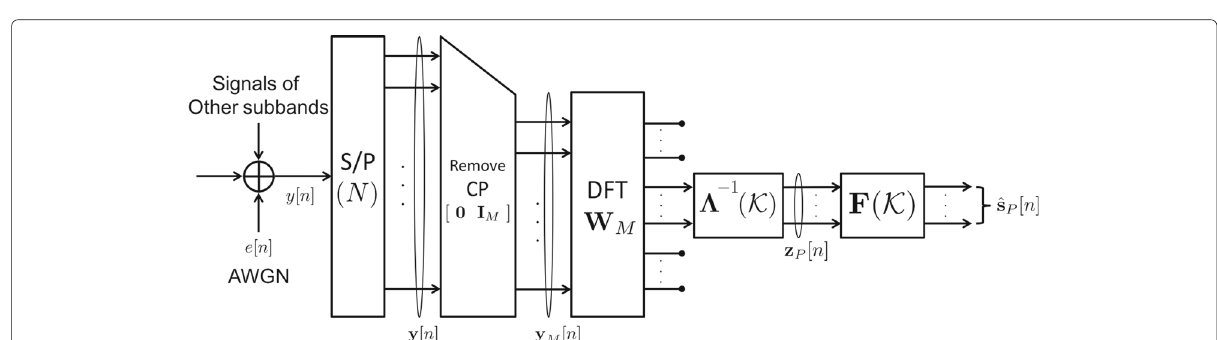
Fig. 2 Block diagram of the